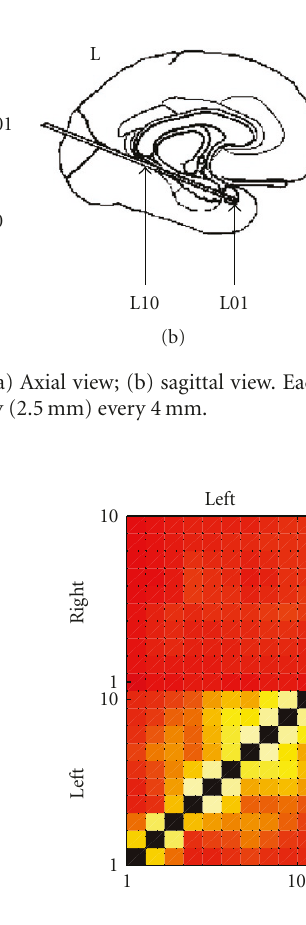
Figure 4: Averaged coincidence rates (cid:8) C (cid:9) estimated for all chan- nel combinations of EEG data recorded during the seizure-free intervals. Note the di ff erence in the degree of intrahemispheric synchronization between the focal (left) hemisphere and the nonfocal (right) hemisphere.